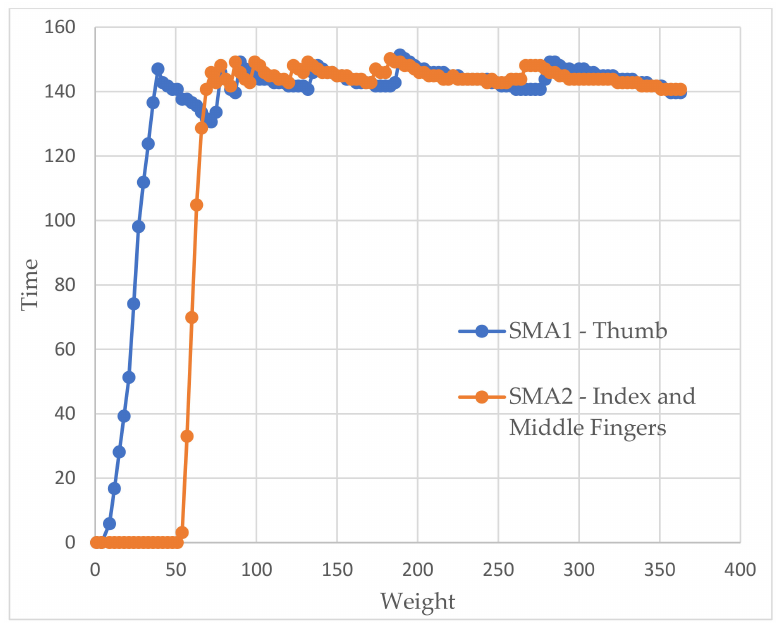
Figure 14. Weight vs time graph for the glove test with a simulated weight of 150